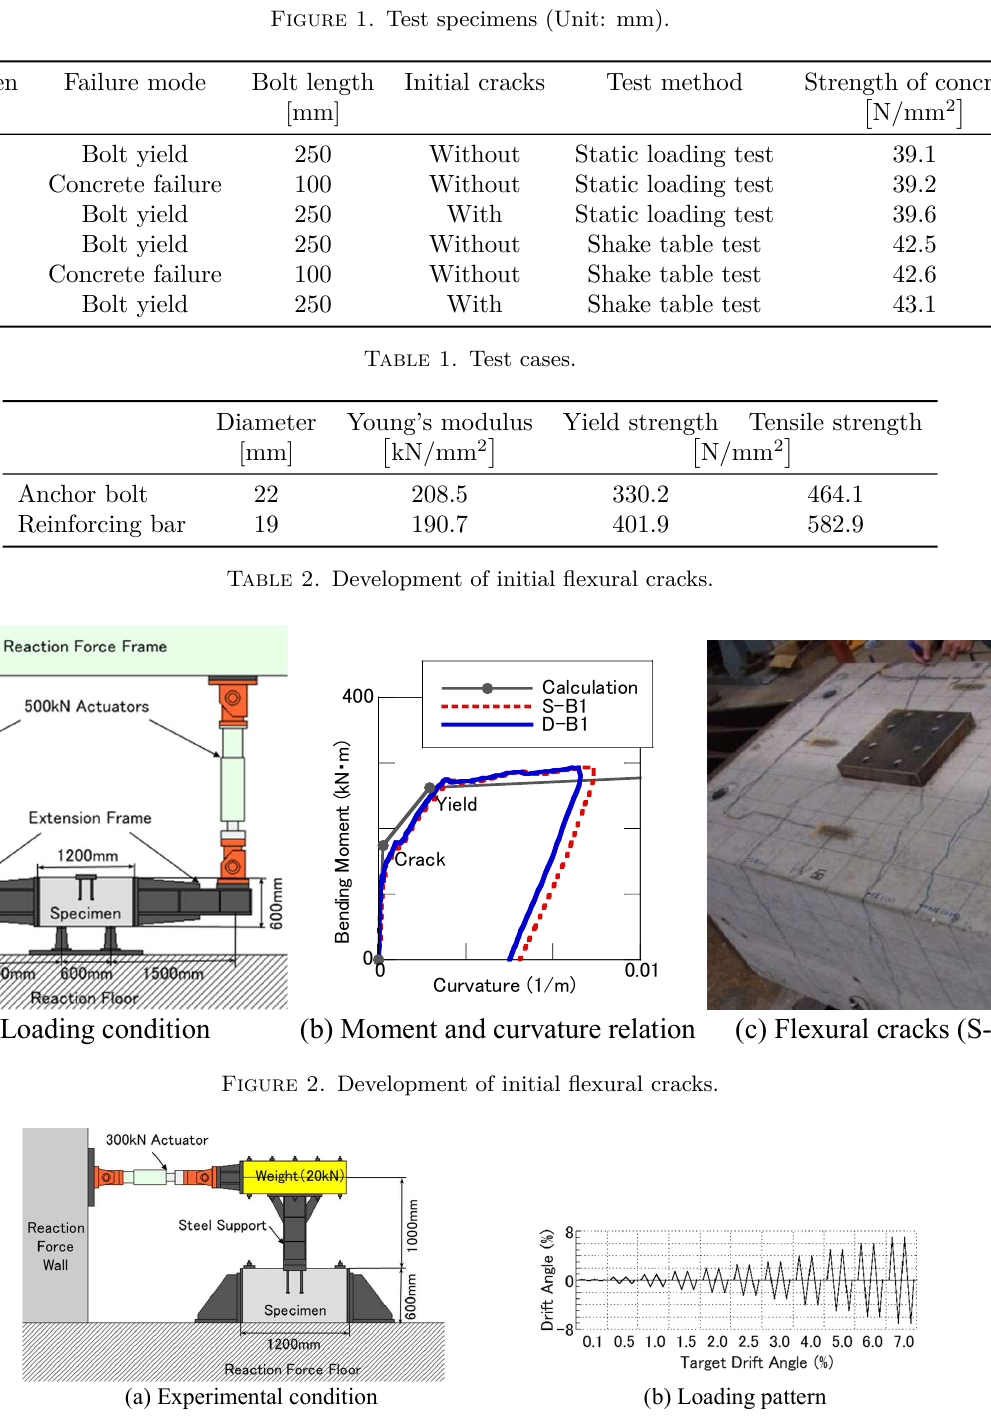
Figure 3. Loading conditions in the static loading